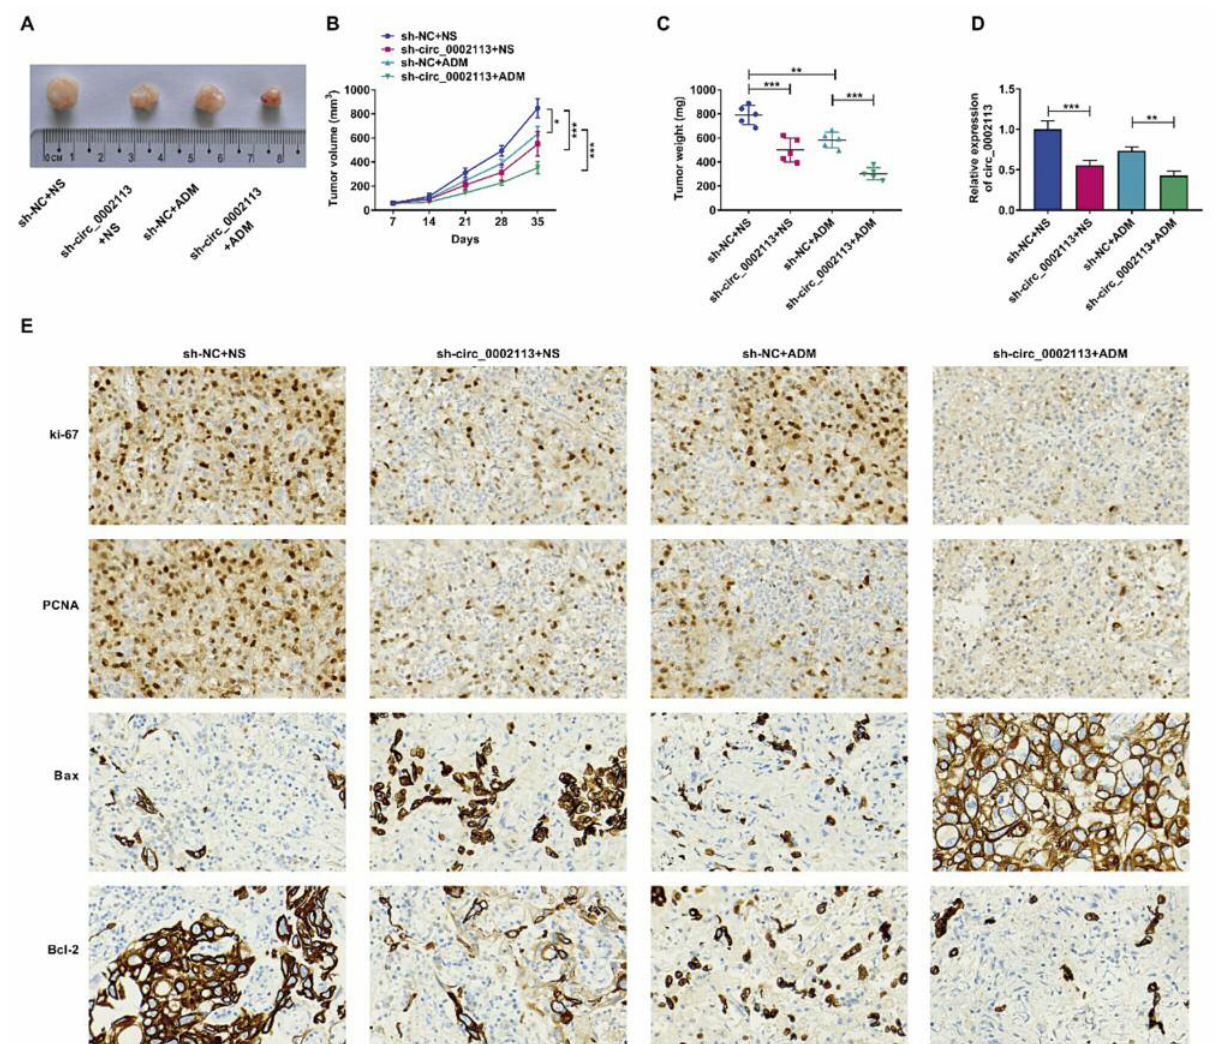
Fig. 3. Circ_0002113 downregulation enhanced ADM sensitivity in mice. (A) Tumor images of sh-NC+NS, sh-circ_0002113+NS, sh-NC+ADM, and sh-circ_0002113+ADM groups. (B-C) Tumor volume (B) and weight (C) of four groups. (D) Circ_0002113 expression was determined by RT-qPCR. (E) The protein levels of ki-67, PCNA, Bax and Bcl-2 were examined using IHC assay in tissues of mice. * p < 0.05, ** p < 0.01, *** p <